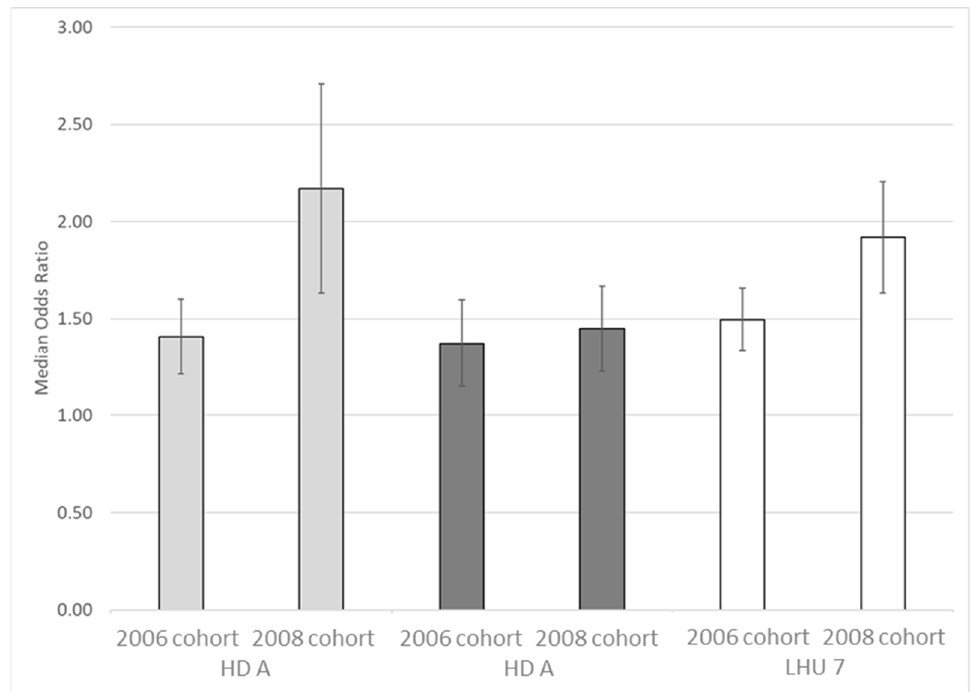
Figure 2. Median odds ratios for first dose of HPV vaccine among 12-year-olds in 2006 and 2008 birth cohorts assisted by primary care pediatricians, adjusted for gender and citizenship. Health Districts of Local Health Unit 7, Veneto region.